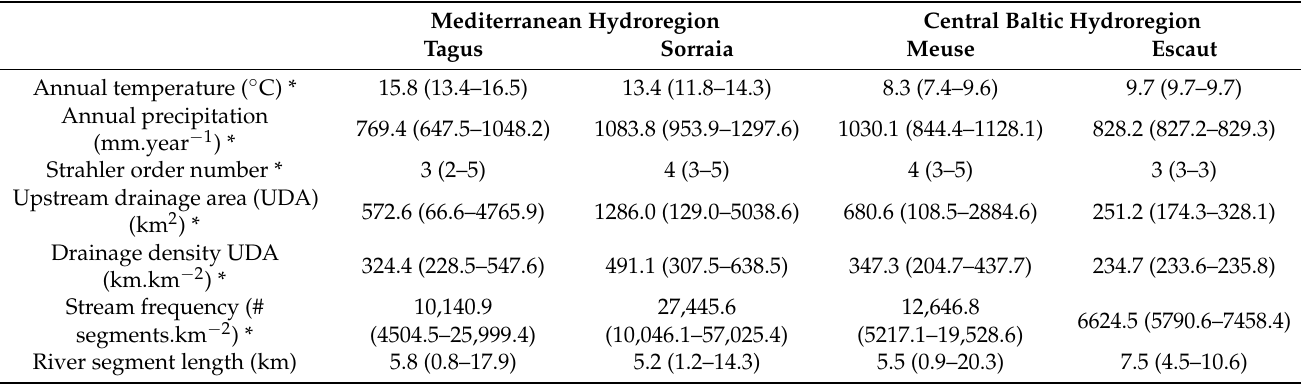
Table 1. Main environmental and geomorphological characteristics of the studied segments (average (min–max)) in the Mediterranean and Central Baltic